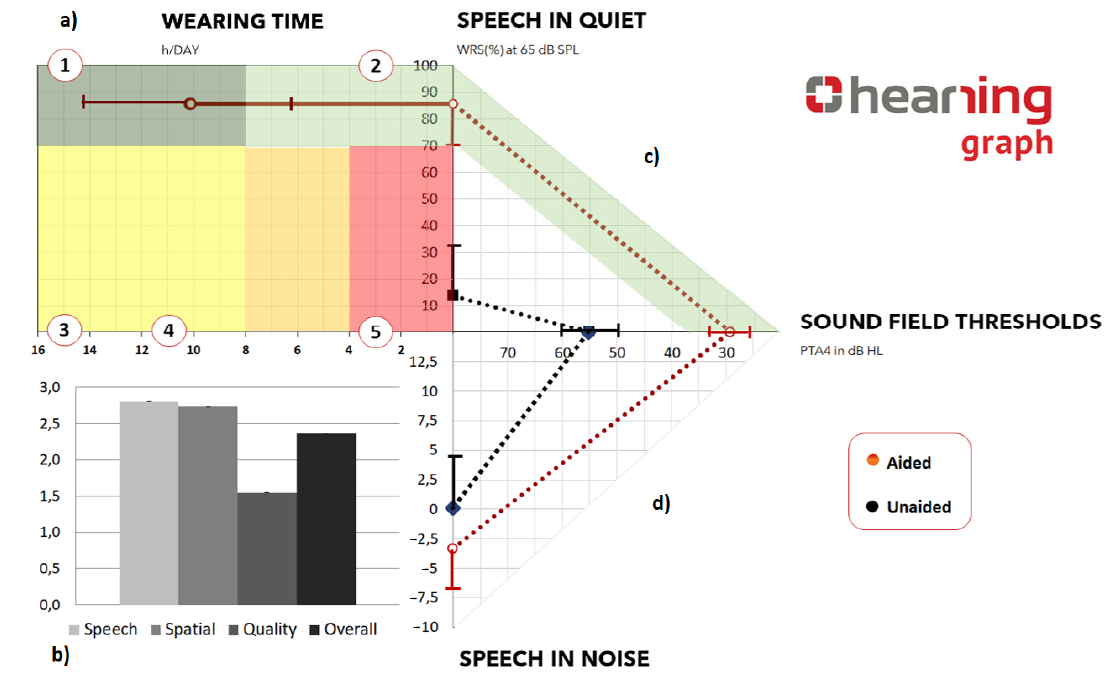
Figure 1. Representative outcomes of 7 subjects [9] ( a ) Top left shows the wearing time (hours/day) as obtained from the patient in relation to WRS. Region 1 indicated that the users achieved ≥ 70% word recognition score in quiet and wore the device for ≥ 8 h/day. This exhibited an ideal situation. The patient reached high listening and acceptable wearing comfort. Region 2 represented word recognition score of ≥ 70% and wearing time of ≤ 8 h/day. It suggested that an optimal speech comprehension in speech test was achieved but the ideal wearing time was not achieved. Region 3 identified ≤ 70% word recognition score and wearing time of ≥ 8 h/day. This indicated ideal wearing time but a need to achieve better speech scores. Region 4 showed ≤ 70% word recognition score and wearing time between 4–8 h/day. Region 5 marked ≤ 70% word recognition score and wearing time between 1 and 4 h/day. ( b ) Bottom Left shows the scores (difference between preop and 3 months postop) of SSQ12 questionnaire. ( c ) Top right displays WRS in % at 65 dB SPL in the aided (red dotted lines) as well as unaided (black dotted lines) condition in relation to the respective PTA values on the x axis. ( d ) Bottom right displays speech performance in noise (in dB SNR) in the aided (red dotted lines) as well as unaided (black dotted lines) conditions in relation to the respective PTA values on the x axis.